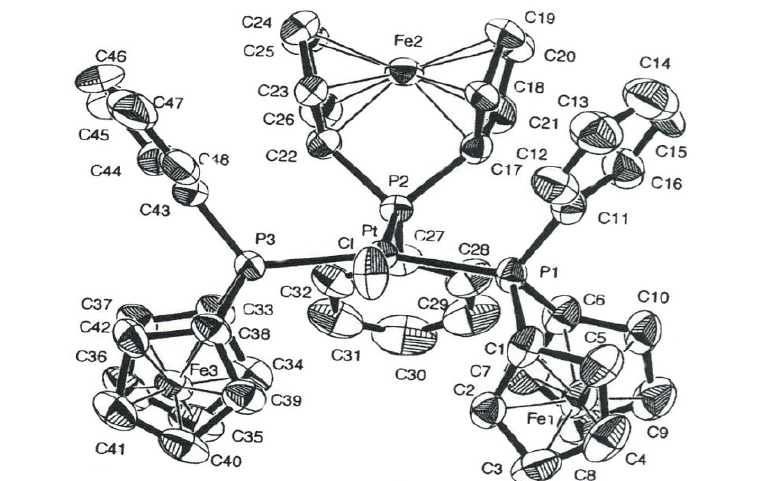
Figure 13. Structure of [ClPt{ η 1 : η 10 -PhP(C